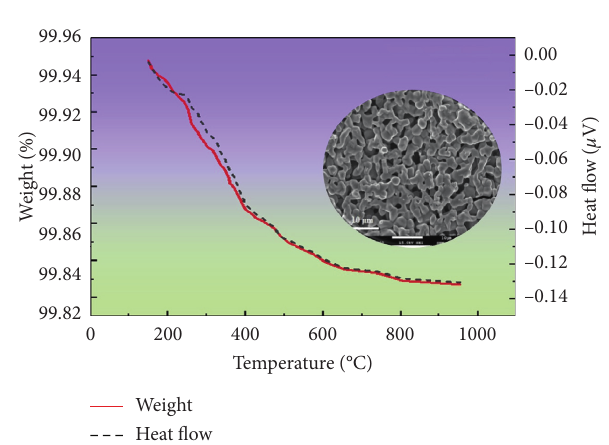
Figure 3: TGA plot of NdSrMn 950 ° C. Single-phase SEM morphology of NdSrMn 2 O 5+ δ